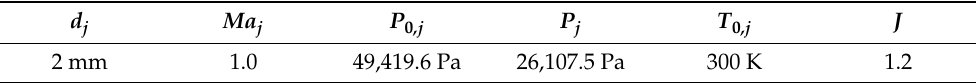
Table 2. Fuel jet parameter